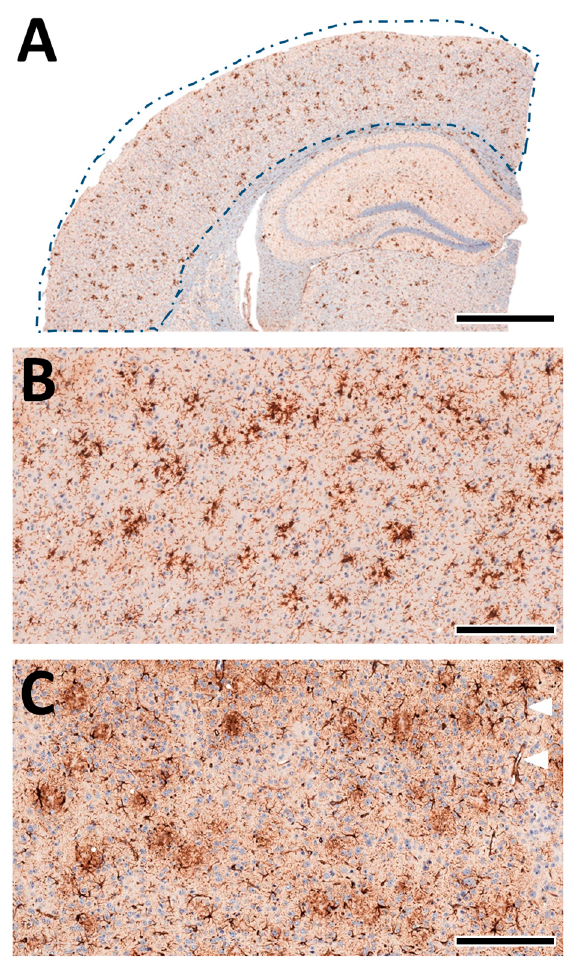
Figure 8. Machine learning-assisted morphological analyses of cortex pathology. ( A ) Schematic presentation of the analysed cortex region (from Figure 4A, left). The brain tissue was automatically detected within the manually marked ROI. ( B ) Staining of IBA1+ cells in the cortex. The microglia nicely accumulate near-insoluble A β deposits and delineate amyloid plaques. ( C ) Staining of GFAP+ cells in the cortex. Astrocytes show a more diffuse pattern with localised perivascular pronunciation (white triangles). Scale bars: ( A ) 1 mm, ( B , C ) 50 µm.